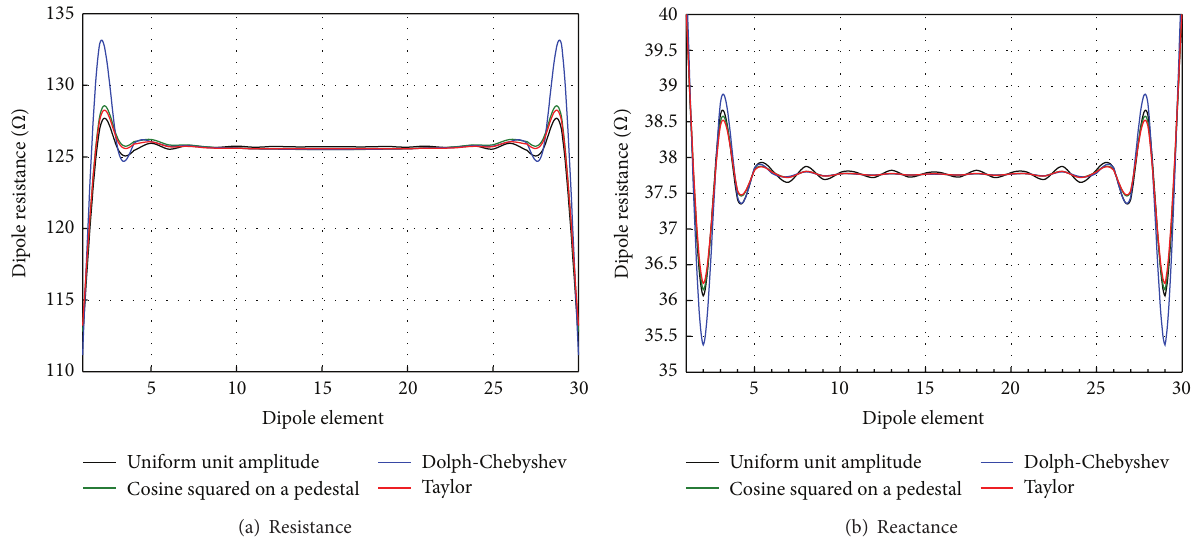
Figure 3: Terminal impedance 𝑍 𝑎